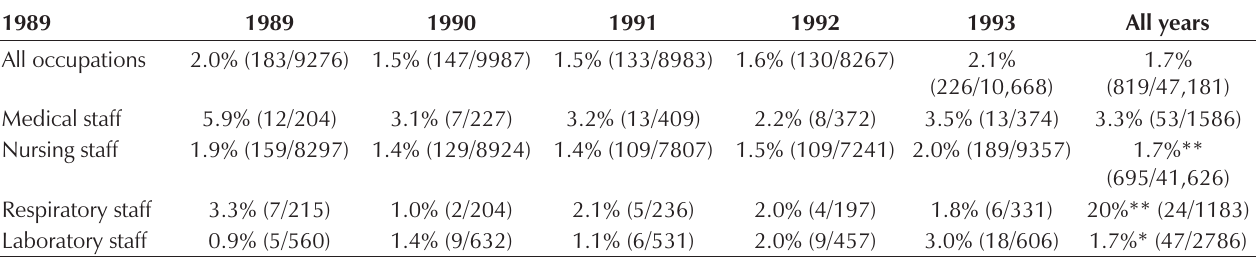
Pooled average tuberculin skin test conversion rates by occupational group (all hospitals)